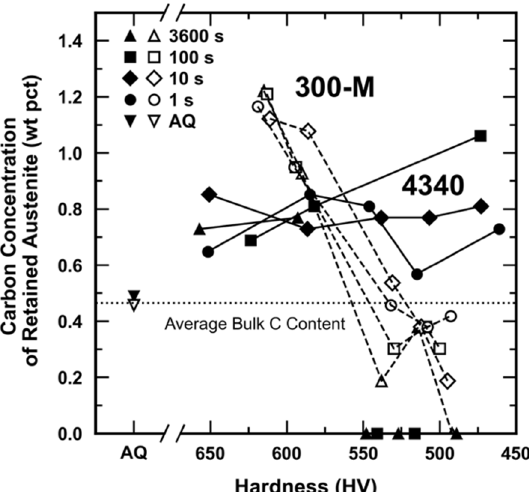
Figure 4. Carbon concentration of retained austenite (C γ , wt pct) as a function of tempered hardness for all time conditions of 4340 (closed) and 300-M (open). Hardness is represented on a decreasing scale. Error bars are not included to facilitate clear identification of trends although average measurement error is ± 0.15 wt pct. Figure is reproduced from [6] with permission.